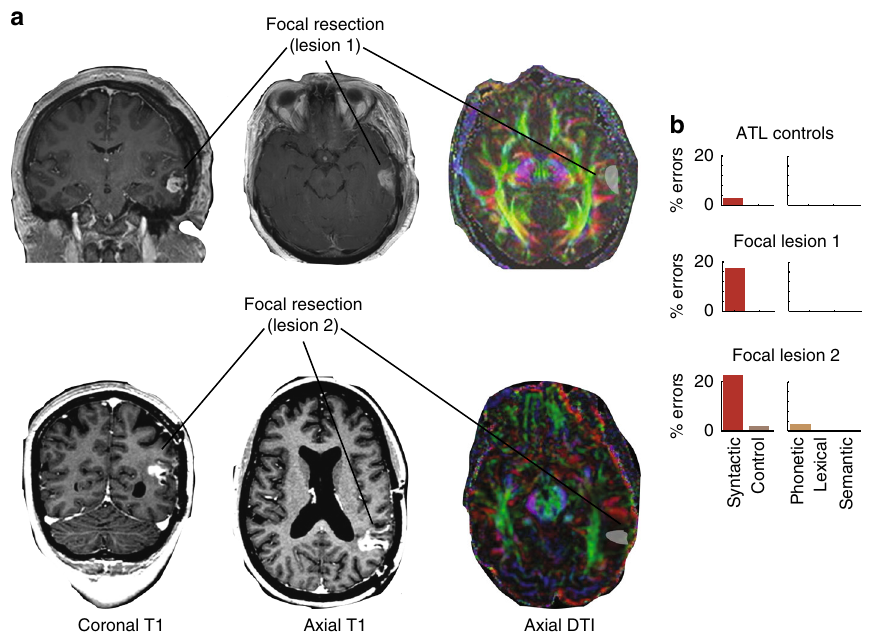
Fig. 7 A focal P-STG gray matter lesion produces a selective de fi cit in functional morpheme production. a Coronal (left) and axial (middle) T1-weighted images show the resection site (in white) and the corresponding cortical ribbon of two patients with focal gray matter lesions. Diffusion tensor imaging (DTI, right) displays the underlying white matter tracts. b Performance of the two participants with a focal P-STG lesion (below) compared to six control participants who underwent extended anterior temporal lobectomies (ATL, above) in the dominant hemisphere